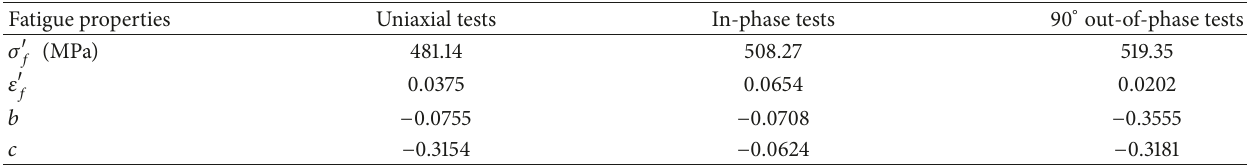
Table 2: Fatigue properties of Q235B welded